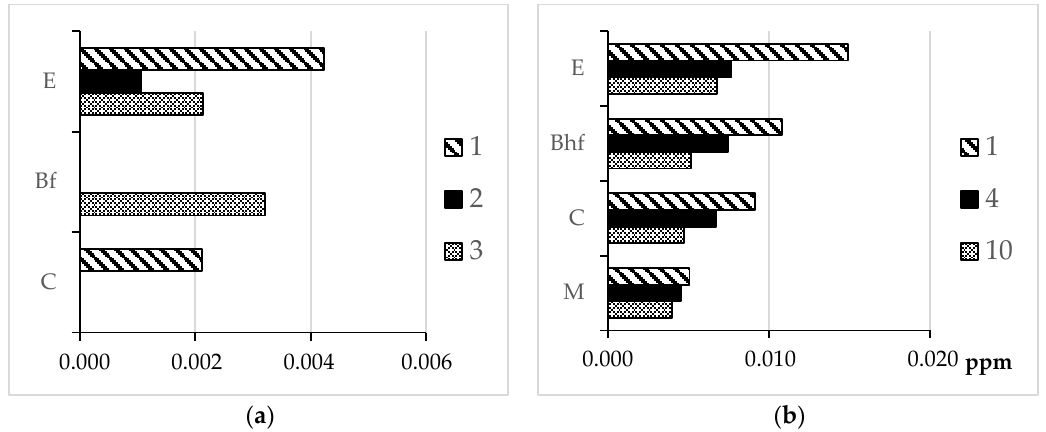
Figure 4. Water-soluble gold distribution in surface sediment horizons within different profiles: ( a ) 1—over the mineralized zone, 2—over the circum-ore zone, 3—out of the mineralized zone; ( b ) 1,4,10—profiles in the Piilola prospecting area.